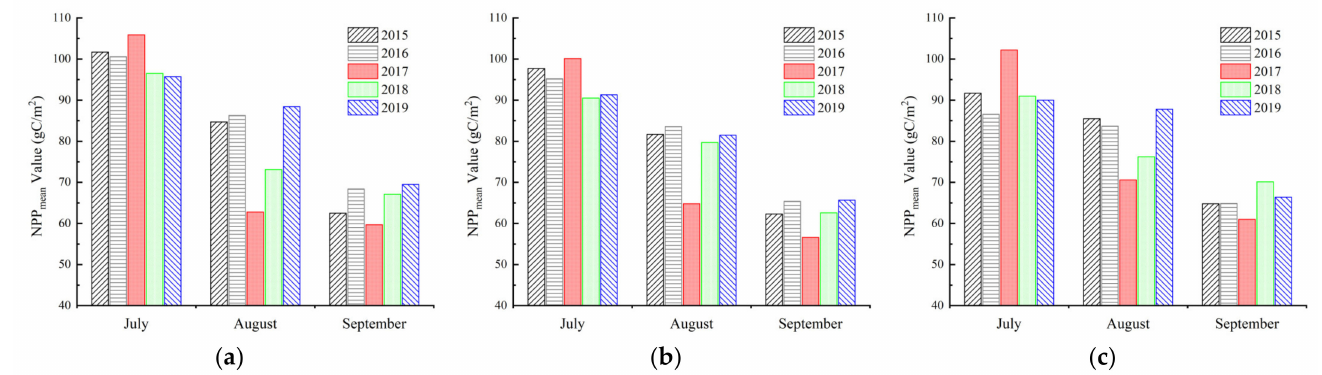
Figure 8. The NPP mean change caused by the three earthquake-induced geohazards in 2015 to 2019. ( a ) Landslide; ( b ) Debris flow; ( c ) Collapse.